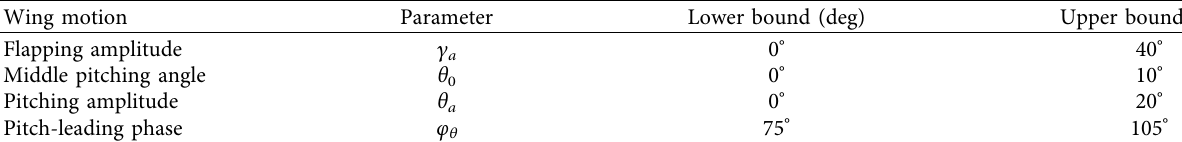
Table 3: Kinematic parameter constraints.